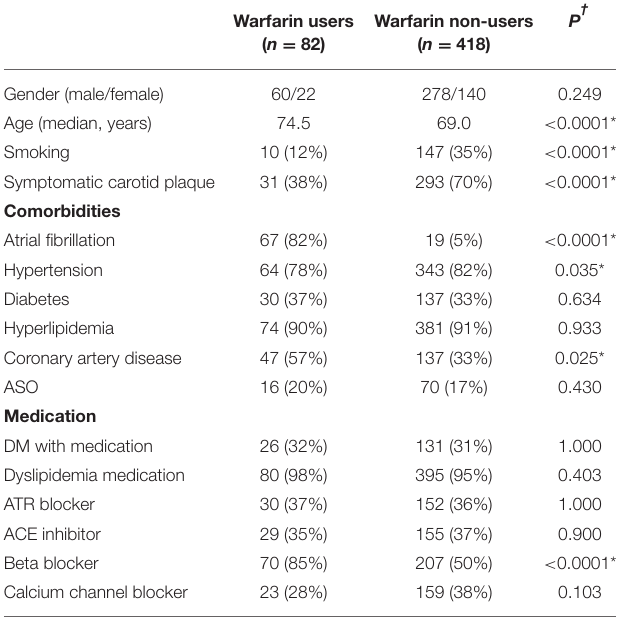
FIGURE 2 | Representative images of calcification in histological samples. (A) Shows histology of the intramural calcification and arrowheads point to areas of calcification. (B) Presents the histology of luminal calcification (arrowheads). For histology, the specimen was cut longitudinally. The luminal side is upward. The scale bar is 500 µ m.